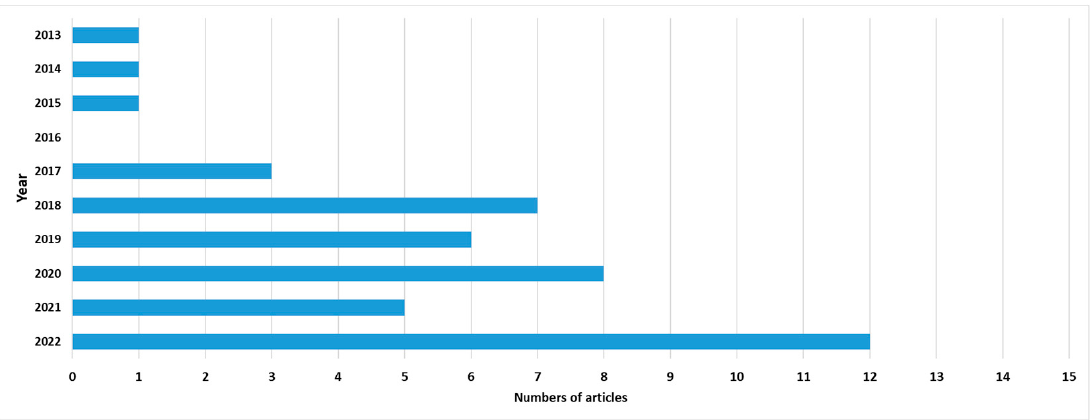
Figure 2. Annual publication trend of articles for biometric analysis in design cognition.